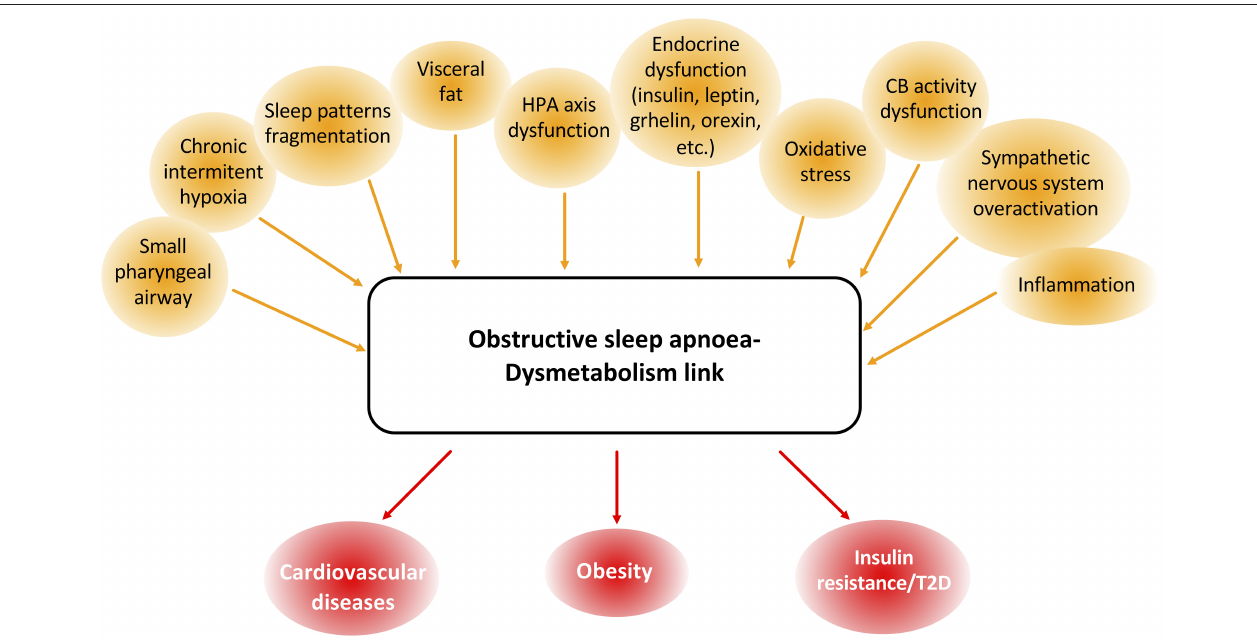
FIGURE 1 | Common features and associated pathologies to obstructive sleep apnea (OSA) and dysmetabolism. OSA and dysmetabolism are associated with many common dysfunctional parameters, namely body structure and composition and endocrine, peripheral nervous system, inflammatory and oxidative stress pathways. These shared patterns between OSA and dysmetabolism are also responsible for the development and progression of many cardiometabolic dysfunctions like cardiovascular disease, obesity, and type 2 diabetes (T2D).